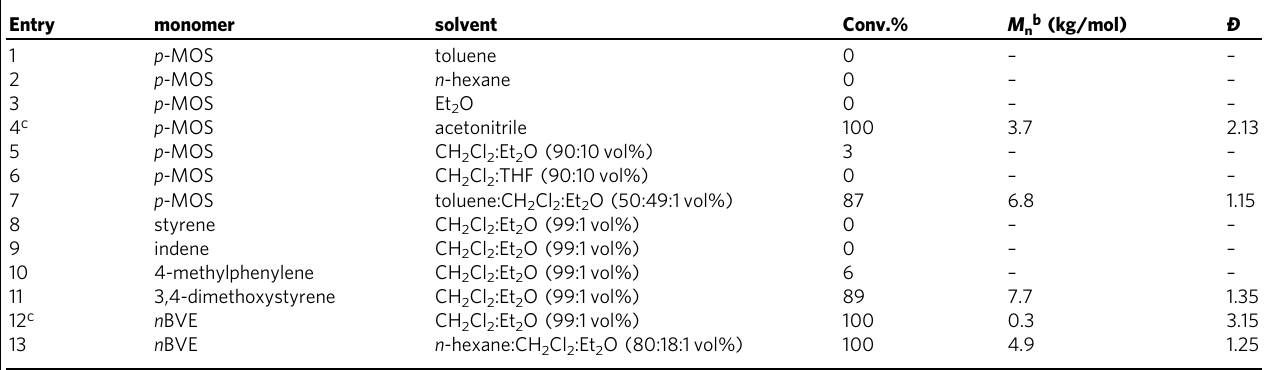
Table 2 Details for polymerization with different solvents and monomers a .